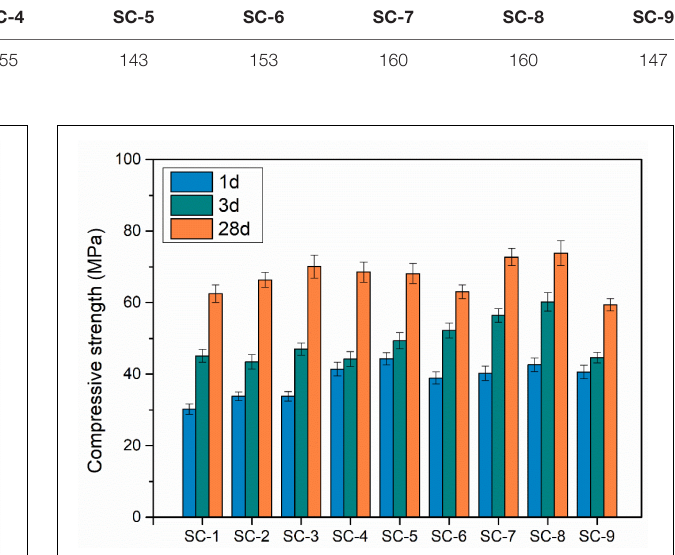
FIGURE 6 | Flexural strength of CSA-ECC specimens after curing for 1, 3, and 28 days.